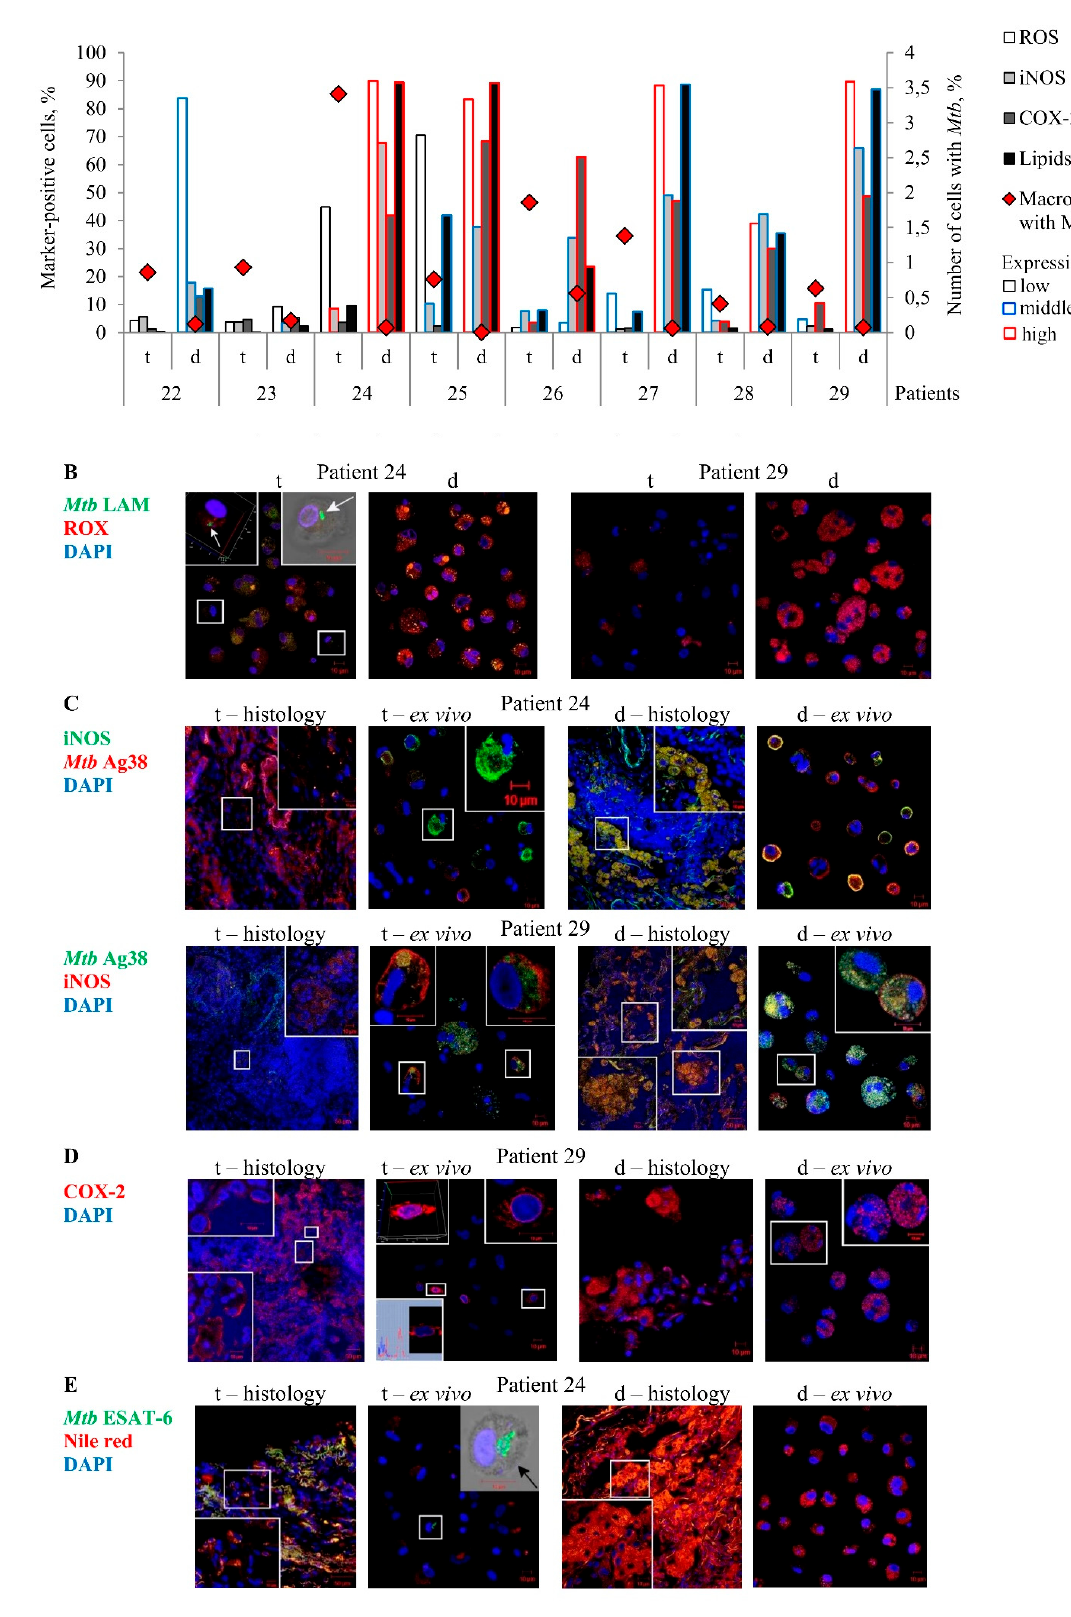
Figure 4. For the same TB patients, Mtb -infected alveolar macrophages are mainly found in the ex vivo cell cultures obtained from tuberculoma walls (t) with the lowest production of ROS, iNOS, COX-2, and lipids in very few cells, but not from